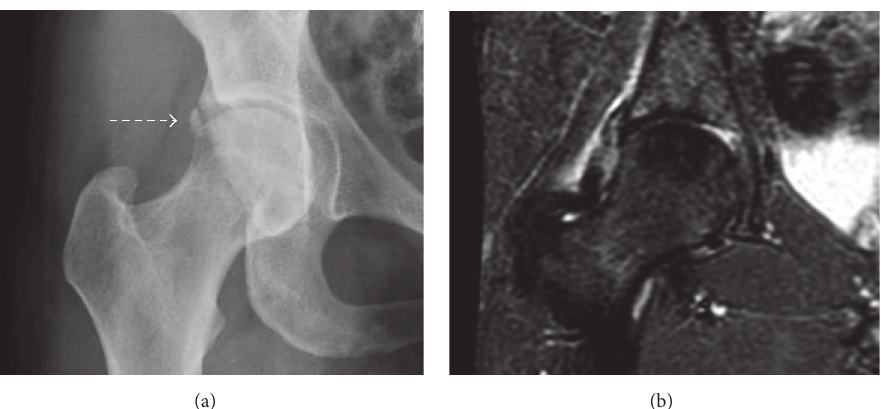
Figure 14: Calcific periarthritis of the hip. (a) and (b) Calcific periarthritis of the hip (dash arrow) presents as periarticular calcifications. In the inflammatory phase of the disease, associated soft tissue edema (image (b)) can help differentiate calcific periarthritis from an os acetabuli.